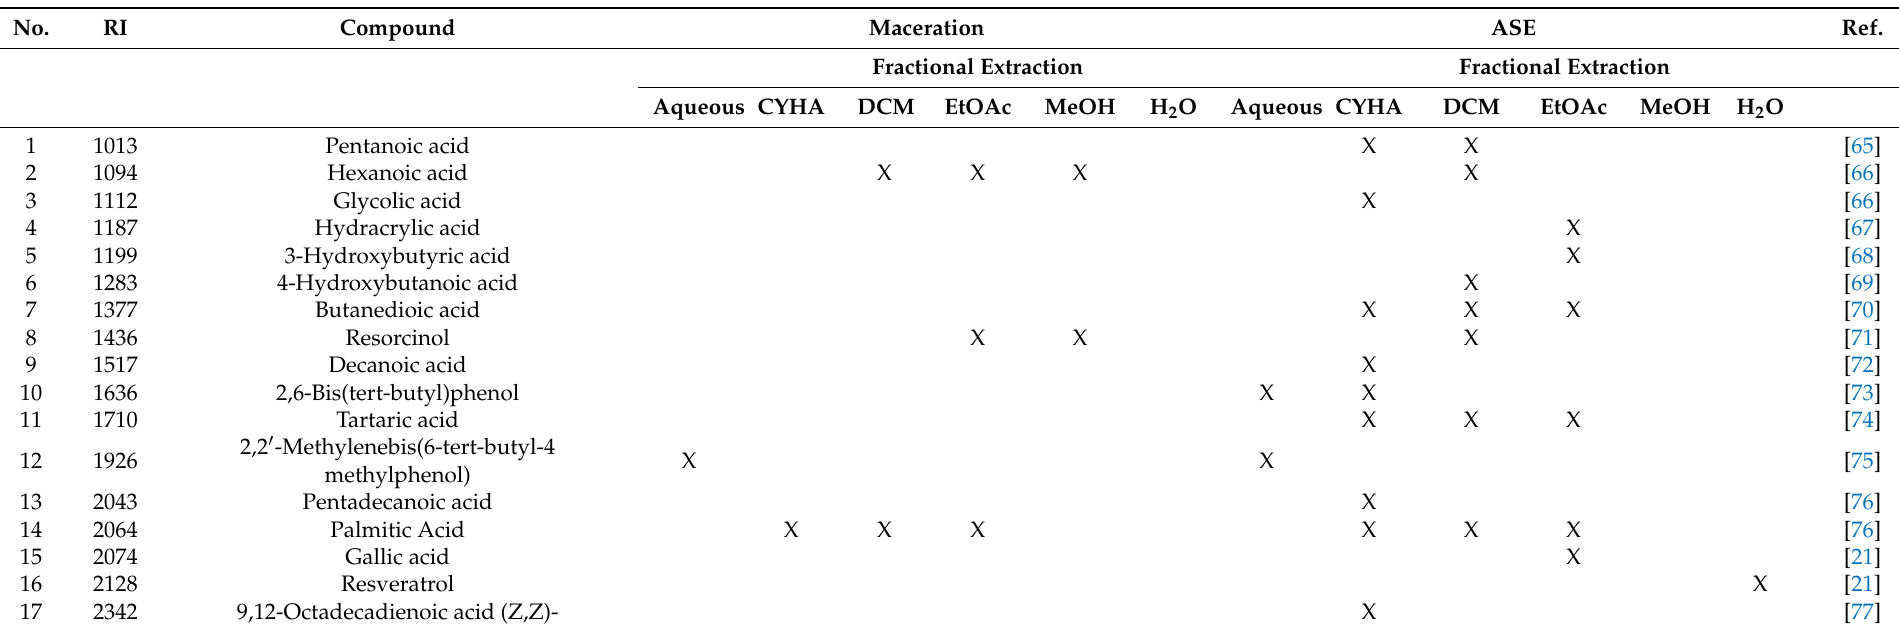
Table 5. Identification of volatile compounds by GC-MS of the extracts of V. vinifera stem (with derivatization) ) (CYHA: cyclohexane, DCM: dichloromethane, EtOAc: ethyl acetate, MeOH: